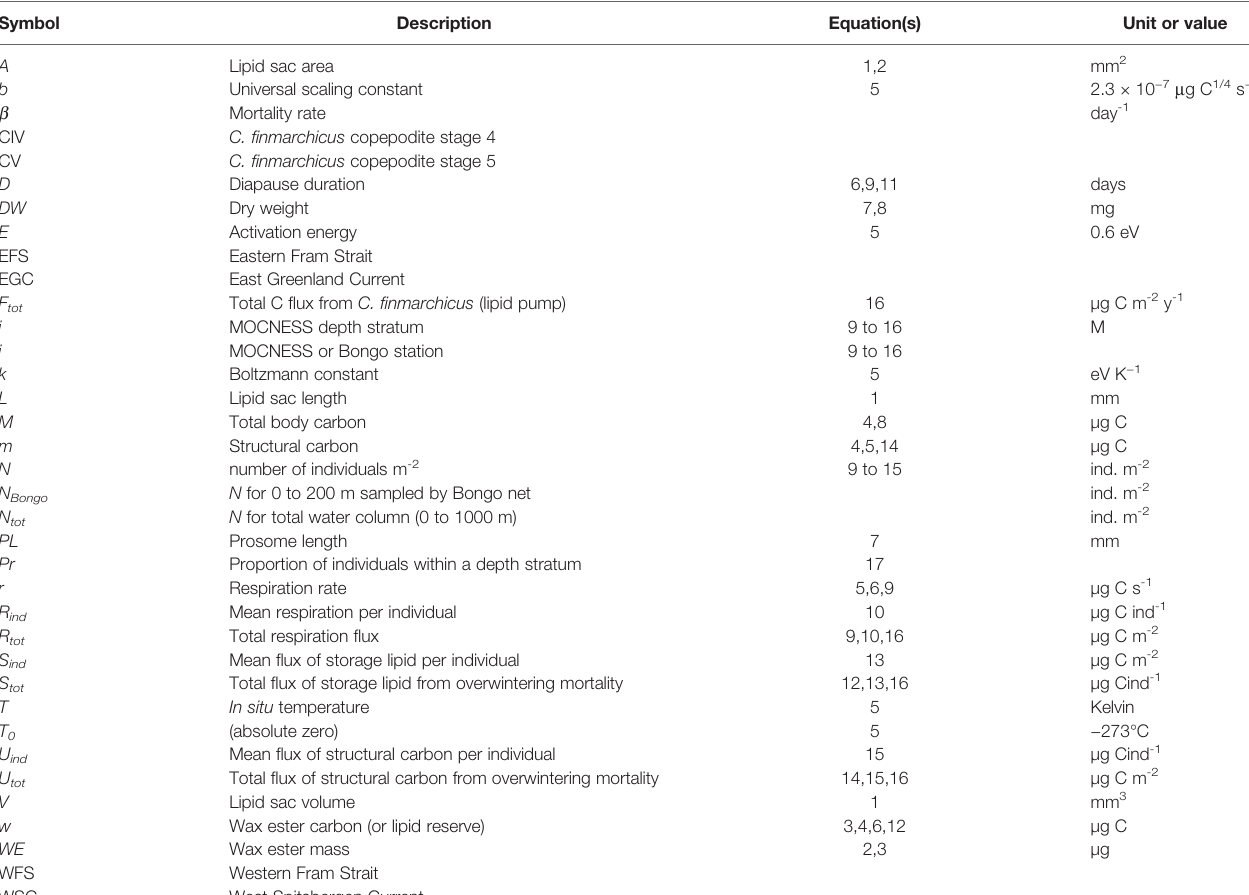
TABLE 2 | Symbols, descriptions, units and constants used in equations and